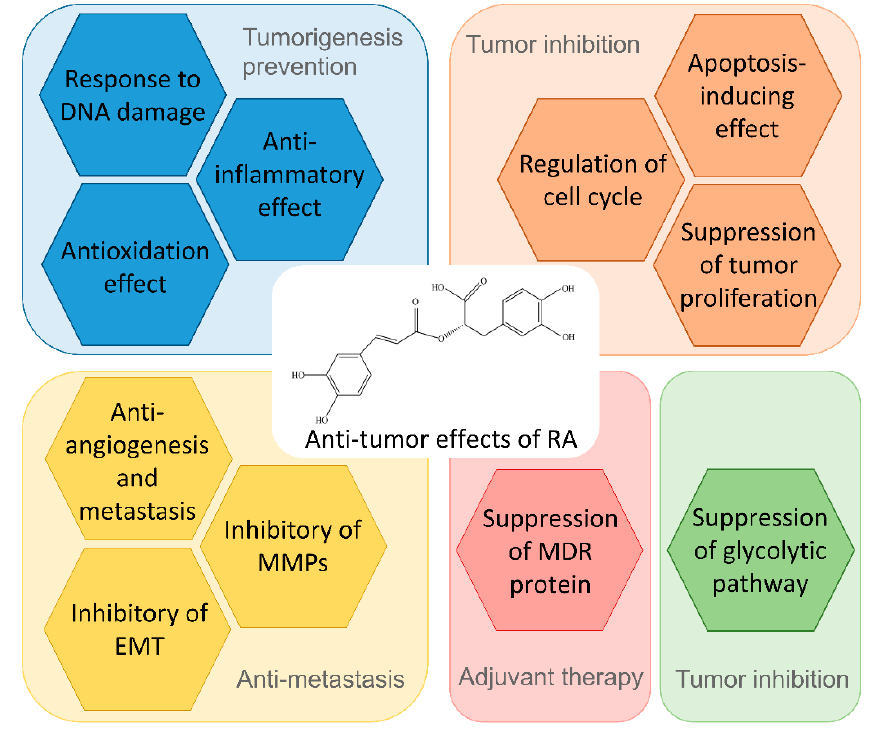
Figure 1. Summary of anti-tumor effects of RA.